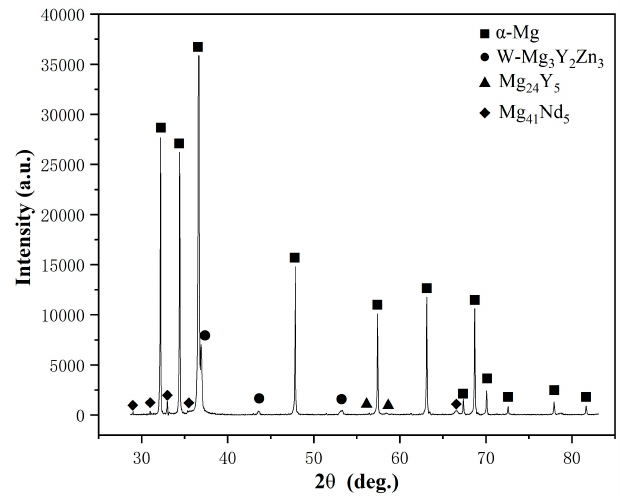
Figure 2. XRD pattern of the heat-treated Mg–Zn–Y–Nd alloy. TEM observations on the heat-treated Mg–Zn–Y–Nd alloy reveal that the coarse secondary phase along grain boundary is the Mg 3 Y 2 Zn 3 phase, as shown in Figure 3a. The inset selected area electron diffraction (SAED) pattern confirms the formed Mg 3 Y 2 Zn 3 phase with the space group of Fm3m and the face-centered cubic crystal lattice with a lattice constant of a = b = c = 0.6833 nm. The further characterization on precipitates inside the grain exhibits that some of them are the Mg 24 Y 5 phase, as shown in Figure 3b. Combining with the inset SAED pattern, it can be determined that the Mg 24 Y 5 phase has the space group of I-43m and body-centered cubic crystal lattice the with lattice constant of a = b = c = 1.1204 nm. In addition, the SAED pattern also reveals that the Mg 24 Y 5 phase has orientation relationships with the α -Mg matrix, which can be described as [ 111 ] // [ 0001 ] α − and ( 101 ) // ( 1010 ) α − . Such orientation relationships agree with the previous research [19]. In addition, the Mg 24 Y 5 phases in the grain